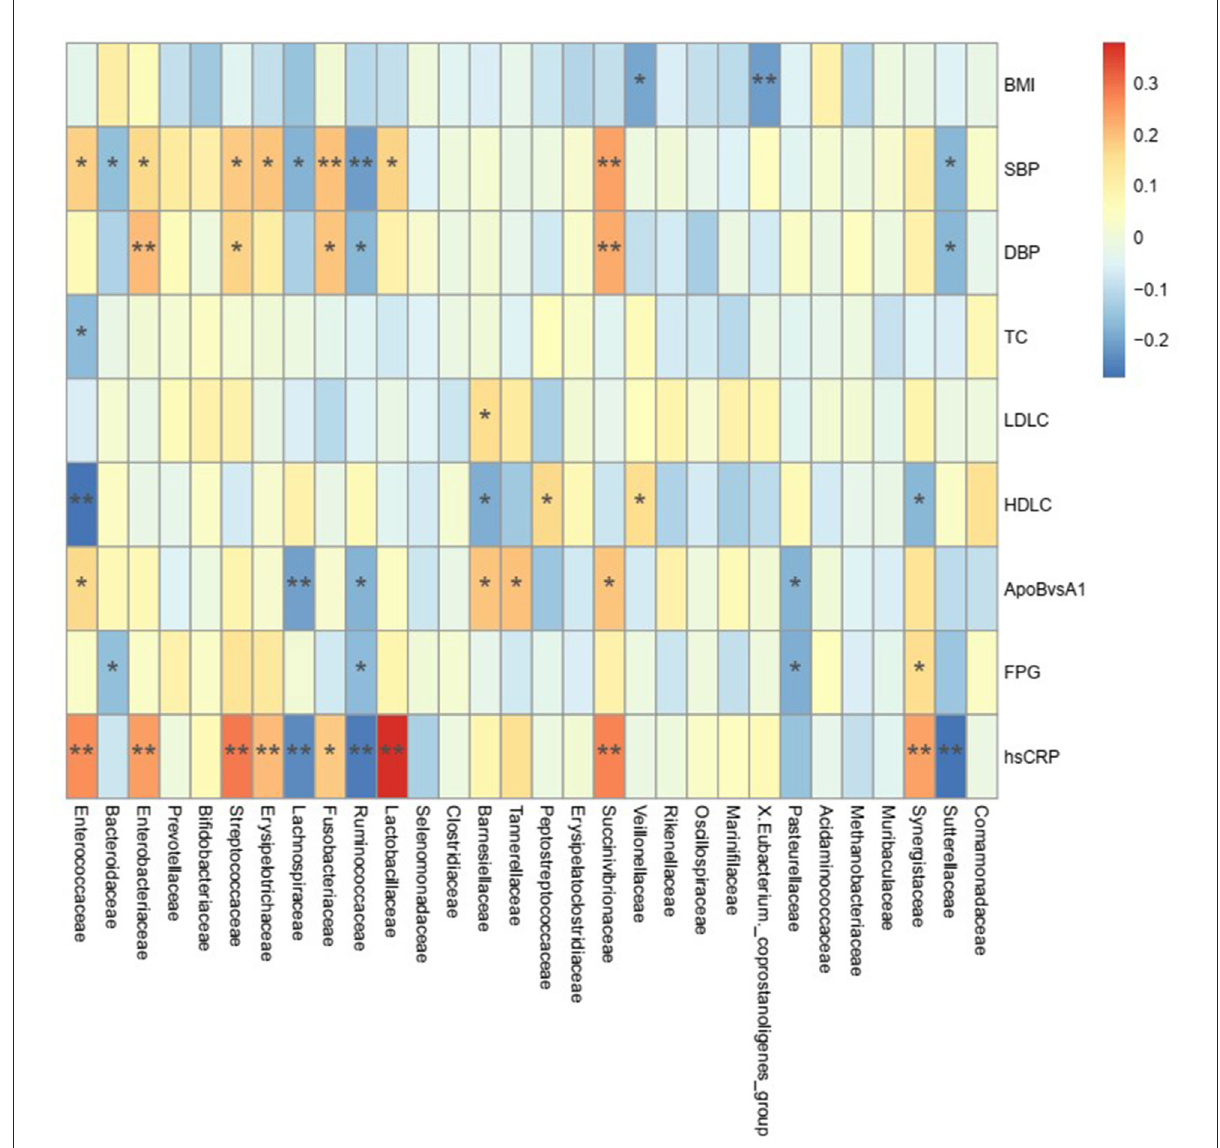
FIGURE3 Association between gut microbiota and traditional risk factors of ischemic stroke. The heat map of Spearman’s rank correlation coefficients of top 30 gut microbiota in family and 9 traditional risk factors (BMI, SBP, DBP, TC, LDL-C, HDL-C, ApoB/ApoA1 ratio, FPG, and hs-CRP, respectively, just as differences of these risk factors between normal controls and ischemic stroke patients were all statistically significant in Table 1). The correlation effect was indicated by a color gradient from blue (negative correlation) to red (positive correlation). The statistical significance was denoted on the squares (* P < 0.05, ** P < 0.01). BMI indicates body mass index; SBP, systolic blood pressure; DBP, diastolic blood pressure; TC, total cholesterol; LDLC, low-density lipoprotein cholesterol; HDLC, high-density lipoprotein cholesterol; ApoBvsA1, apolipoprotein